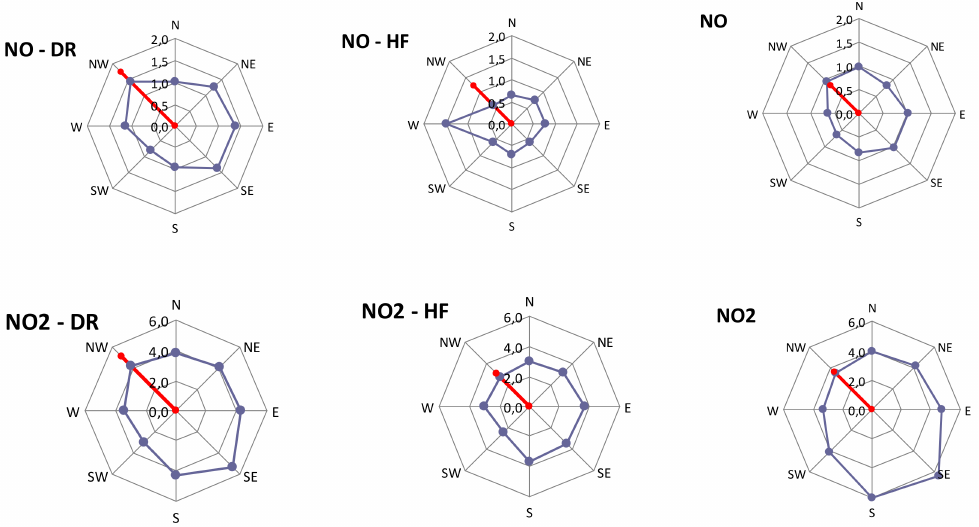
Figure A1. Average levels of NO and NO 2 vs. wind direction measured at the Stary Wiec station during drilling (DR), hydrofracturing (HF), and for the remaining period of measurements. All concentration units are in parts per billion (ppb). The red bars indicate the airmass coming directly from the area of the wells.